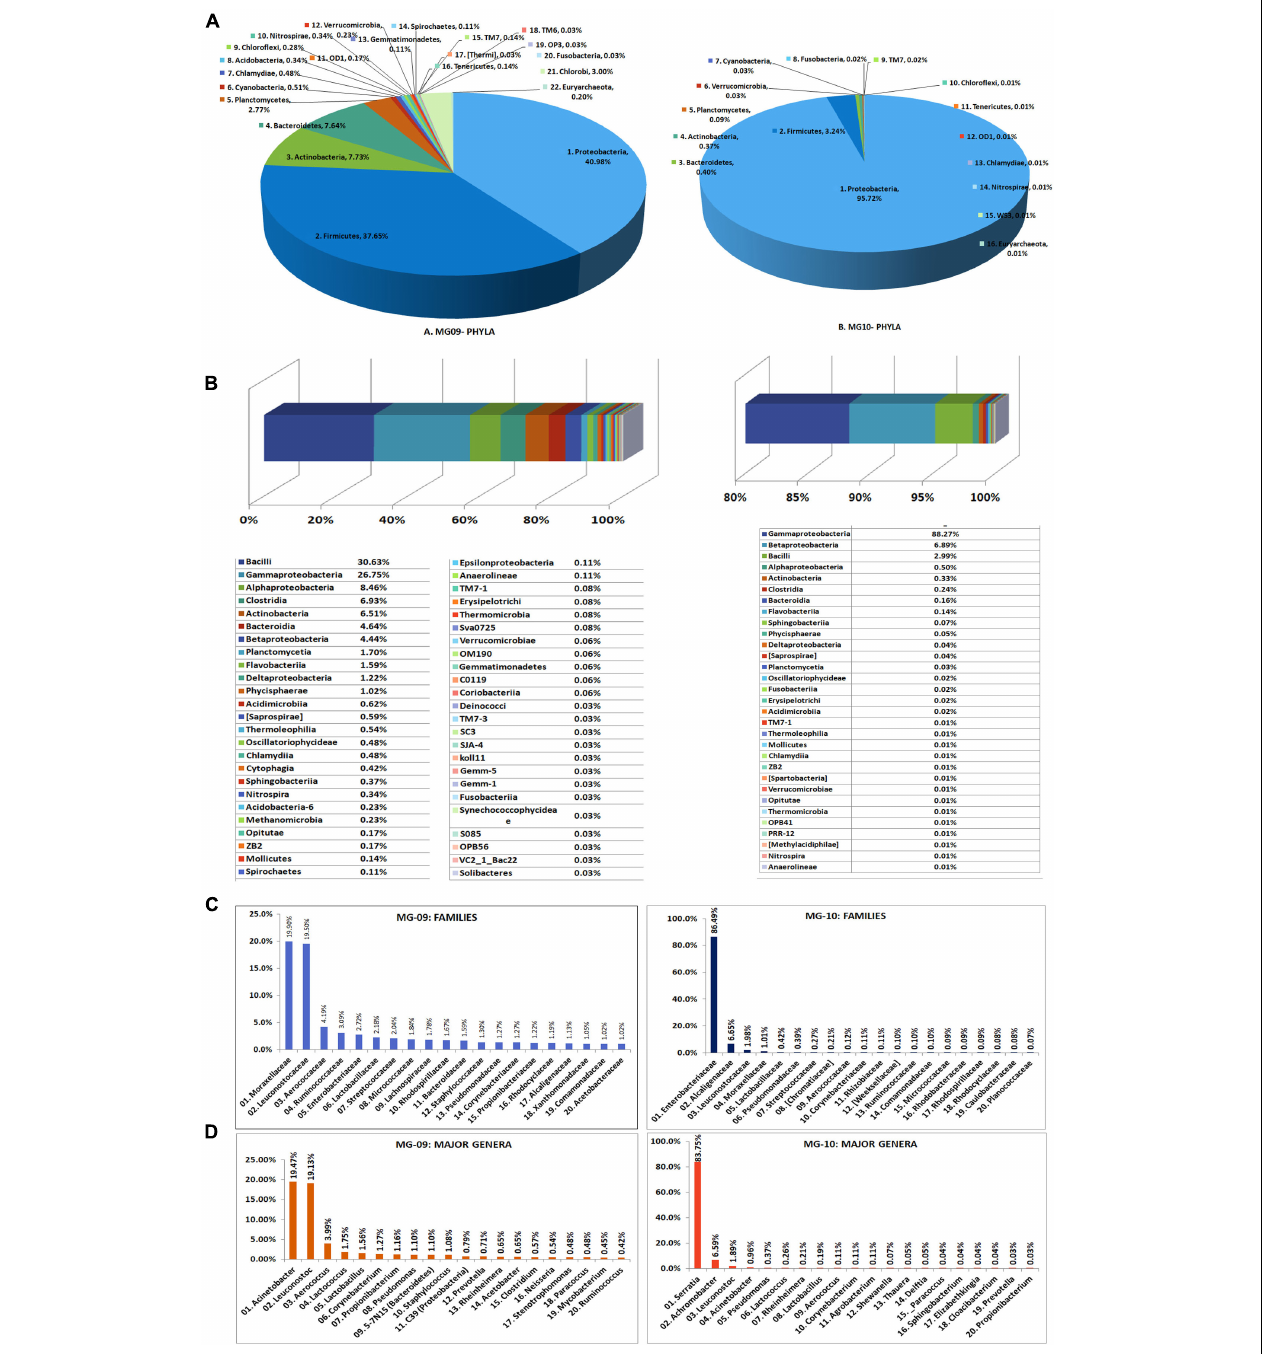
FIGURE 4 | Illumina MiSeq NGS-based bacterial diversity analysis on watermelon seed-embryos with DNA extracted using PowerFood microbial DNA isolation kit (MG09) or Axygen DNA isolation kit (MG10). Distribution of phylogenetic groups based on 16S rRNA gene V3–V4 region taxonomic profiling at (A) phyla and (B) class levels. (C) Major families. (D) Major